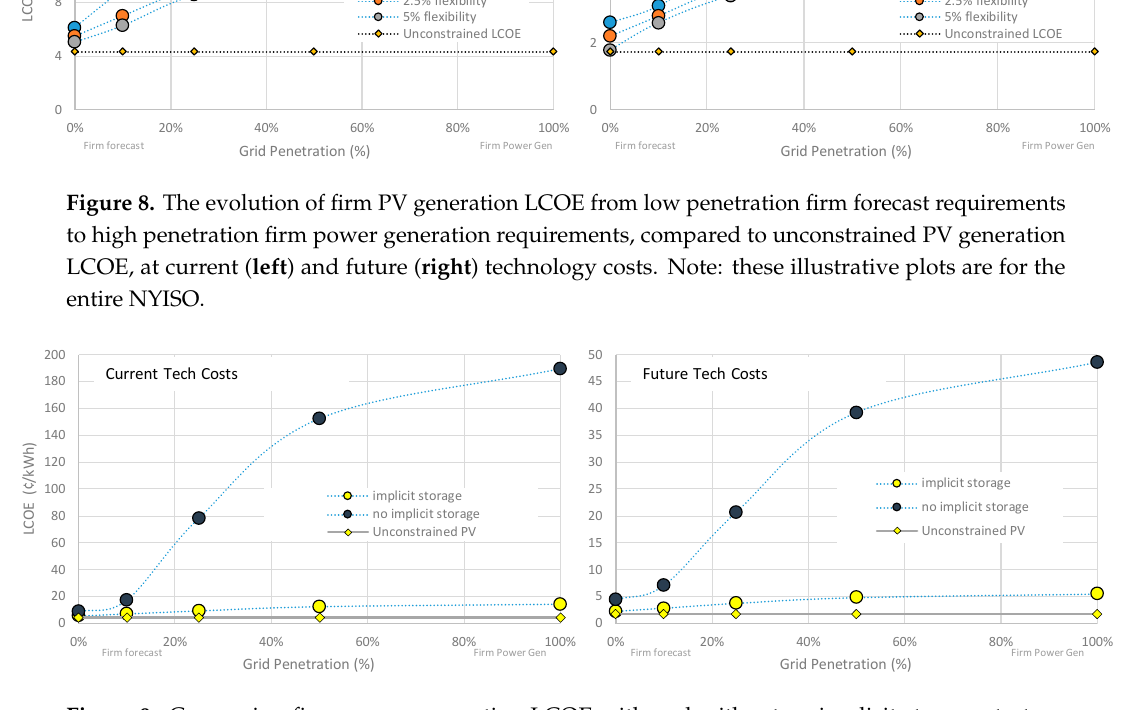
Figure 9. Comparing firm power generation LCOE with and without an implicit storage strategy. Note: this illustrative example is for NYISO-wide at 2.5% flexibility.